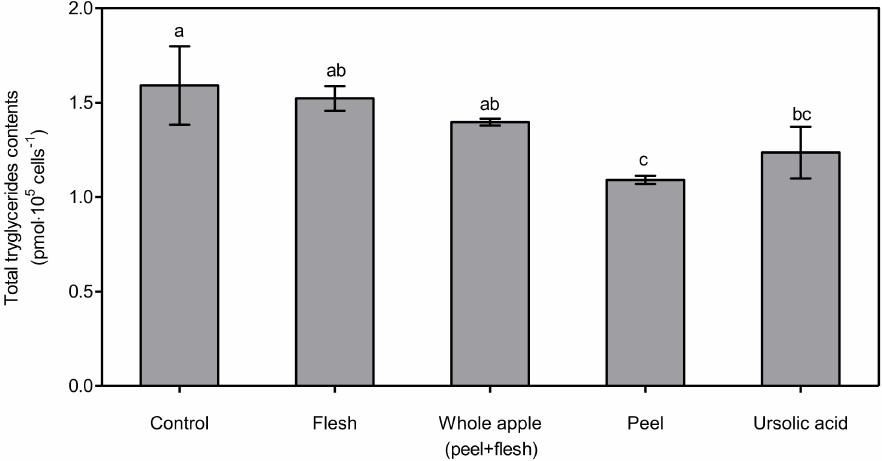
Figure 5. Total triglyceride content determination from 3T3-L1 cells treated with 70% methanol extracts (1 µ g dry powder in 1 mL of DMSO) from peel, flesh, and whole apple (peel + flesh) samples or ursolic acid 5 µ M treated samples. The data represent the mean and standard deviation ( n = 3). Different letters indicate significant differences among the groups according to Tukey’s HSD test at p <